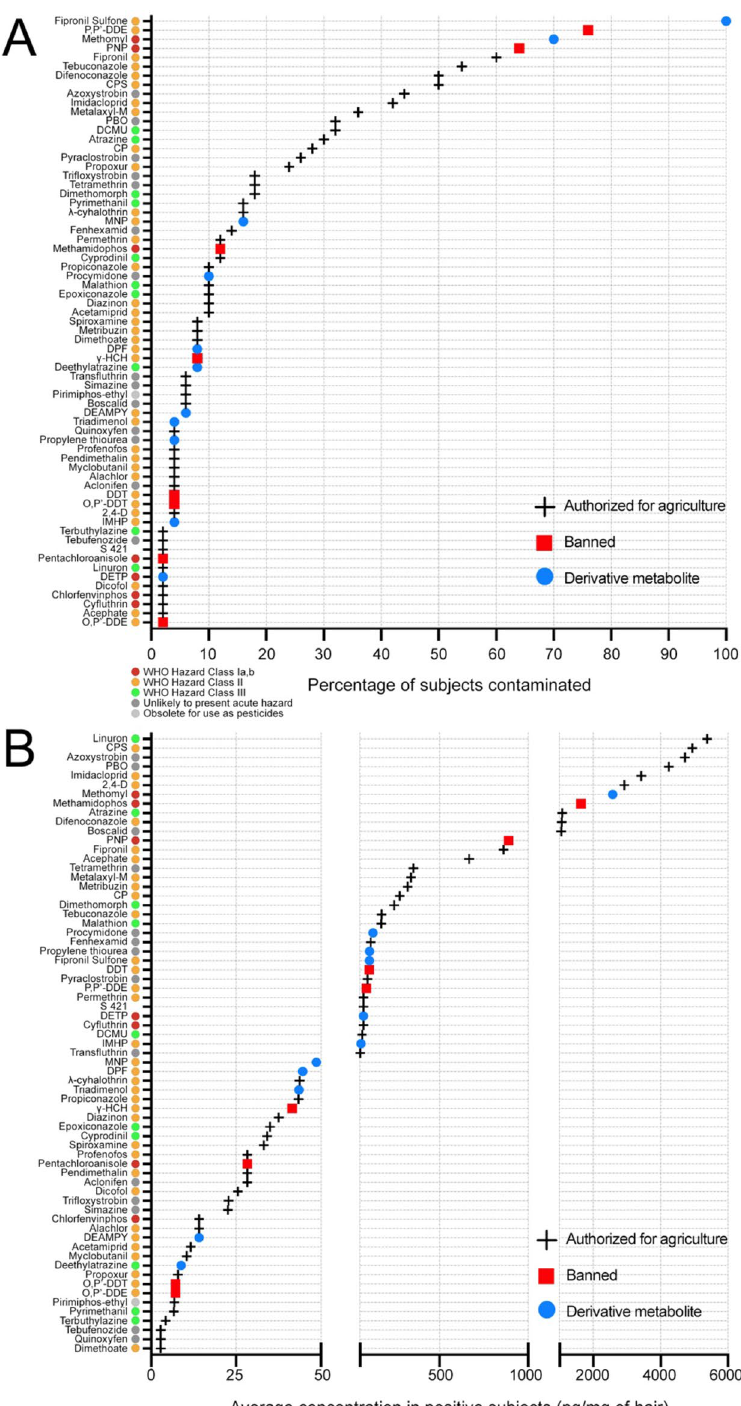
Figure 2. Hair samples of Peruvians from the Central Andes are contaminated with a wide range of pesticides. ( A ) Dot plot displaying the percentage of subjects ( N = 50) exposed to each of the 67 contaminants detected. ( B ) Dot plot displaying the average concentration (pg/mg of hair) in positive subjects (> LOQ) for each of the 67 contaminants. ( A , B ) Crosses: pesticides authorized for agriculture use in Peru; Red squares: pesticide ingredients legally banned in Peru; Blue dots: Pesticide derivative metabolites. Colored dots indicate hazard classes according to the WHO recommended classification of pesticides: Class I, red; Class II, orange; Class III, green; Unlikely to present acute hazard; dark grey; Obsolete for use as pesticides, light